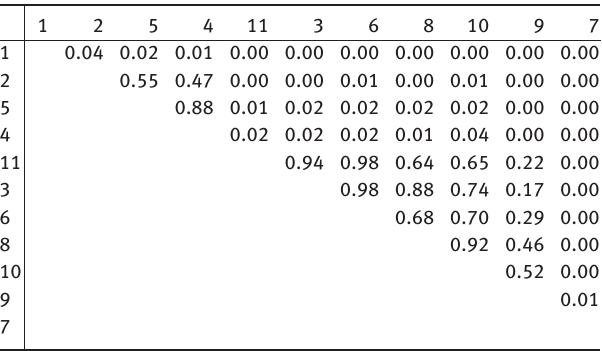
other products. Product 7 is definitively the worst. Note that in this example, the improvement achieved by